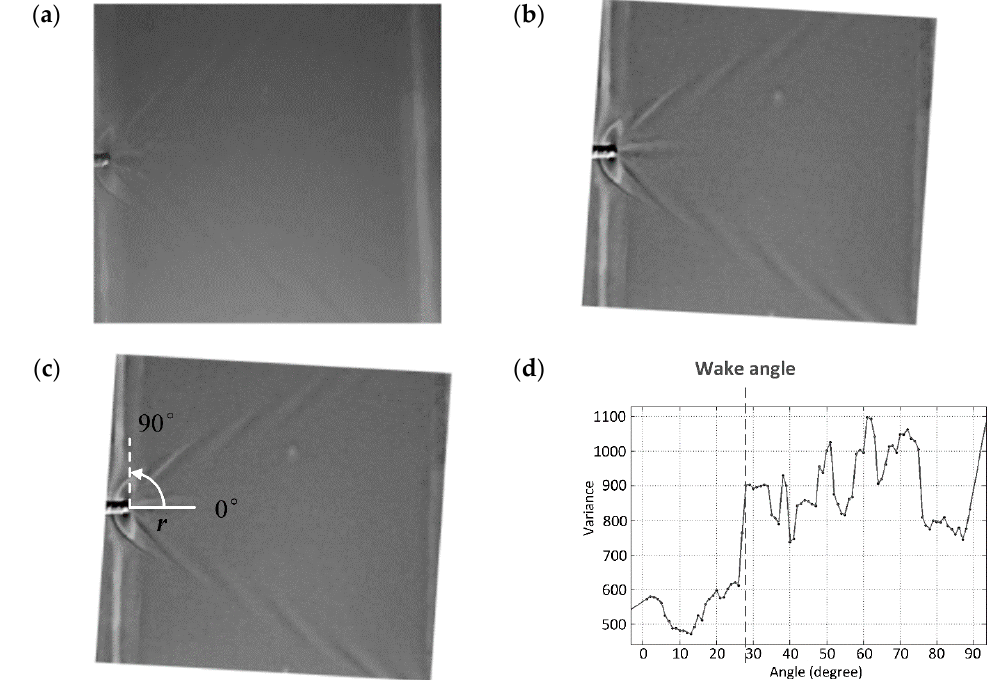
Figure 4. Di ff erent steps of the image processing procedure to determine the wake angle: ( a ) Image smoothing by averaging 30 successive raw images, ( b ) Image enhancement and rotation, ( c ) Calculation of the variance of gray levels along r by scanning from 0 (horizontal line) to 90 degrees (vertical line), and ( d ) The wake angle versus the variance at r = 50 pixel length.